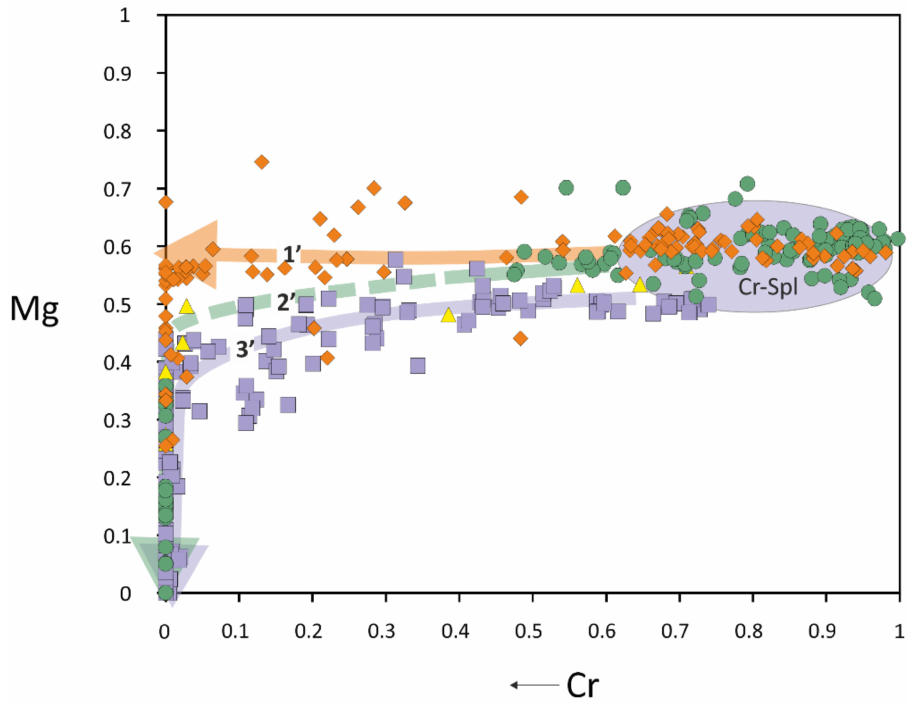
Figure 7. Plots of Mg (apfu) and Cr (apfu) for spinels from ultramafic alkaline rocks of the Chadobets complex. Symbols are as shown in Figure